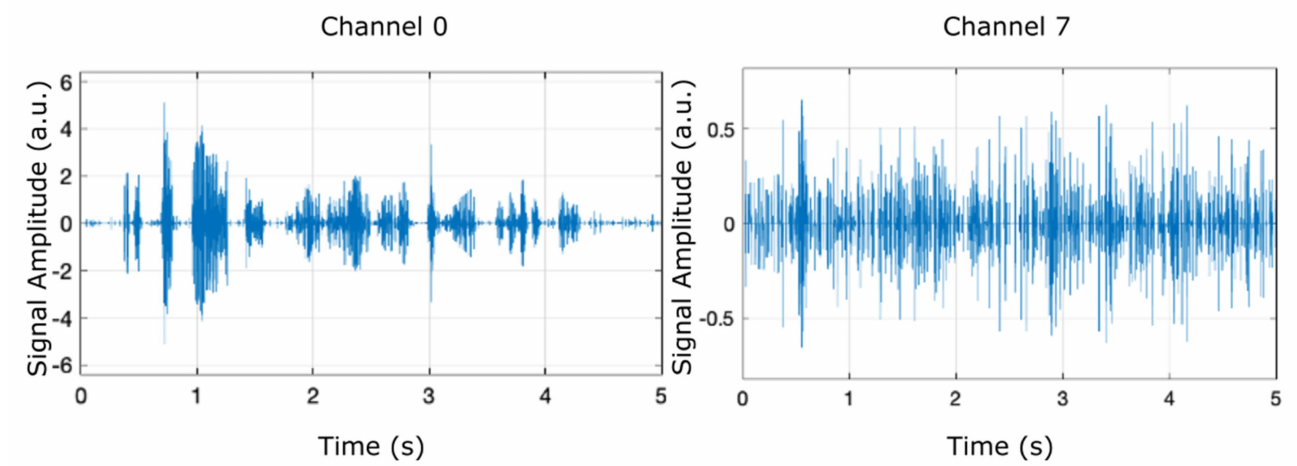
Figure 20. Result of electrical pulse generator for two of the 8 channels (channel 0 and channel 7) with IIR filter, Gaussian noise, temperature and humidity influence, and the denoise block